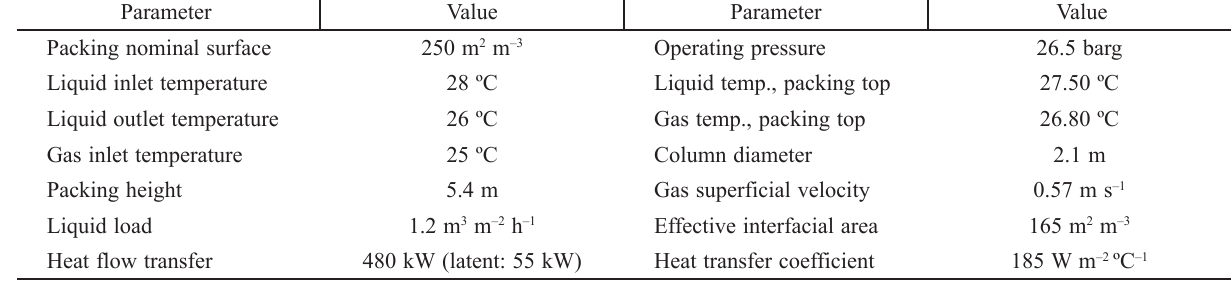
Table 1 – Process and simulation data used for the evaluation of gas – liquid heat transfer coefficient